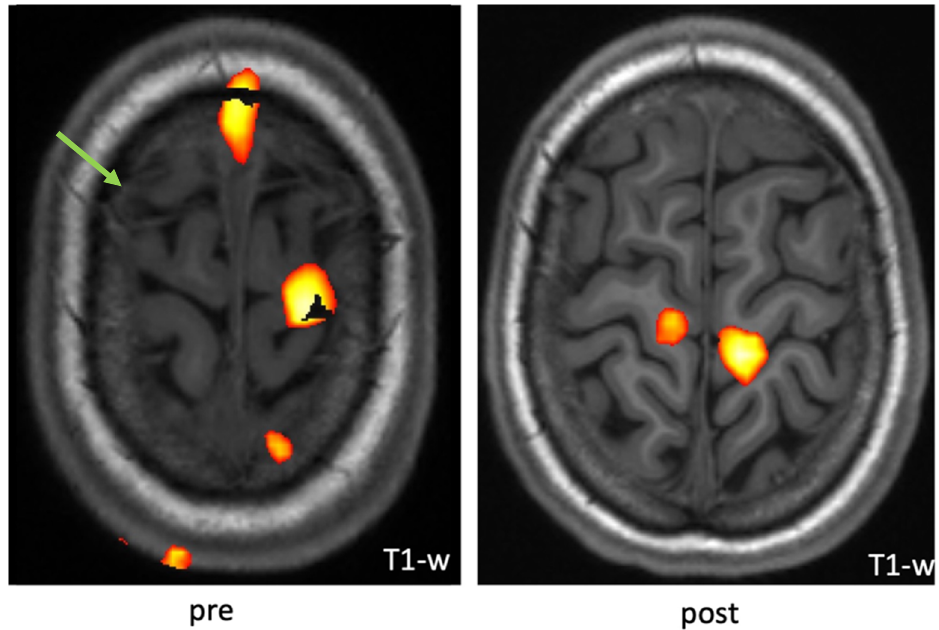
Figure 2. Example fMRI activation pattern upon a voluntary knee ‐ bending task with the patient‘s right leg showing new co ‐ activation of the right primary motor area. The green arrow indicates area of underrepresented activation while knee bending, whereas after hybrid fitting and training, new activation patterns could be observed.